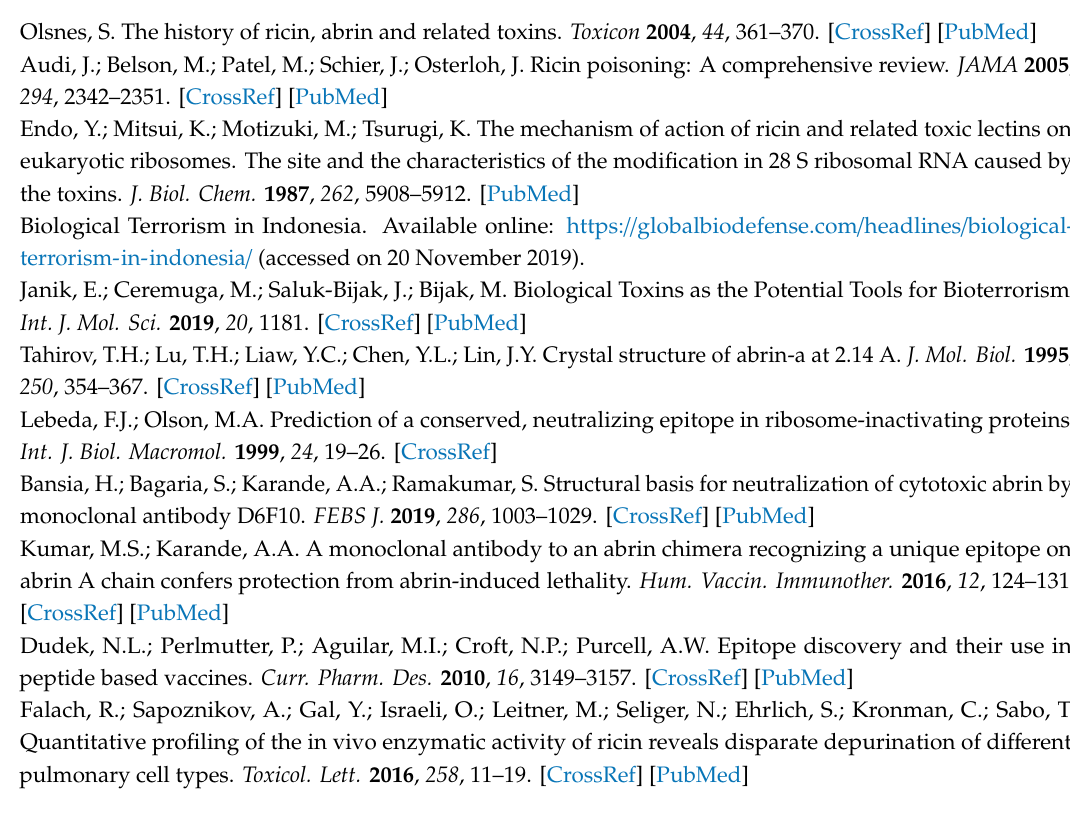
Figure S1: Sequences of 15-mer peptides of ATA and ATB used for binding screening